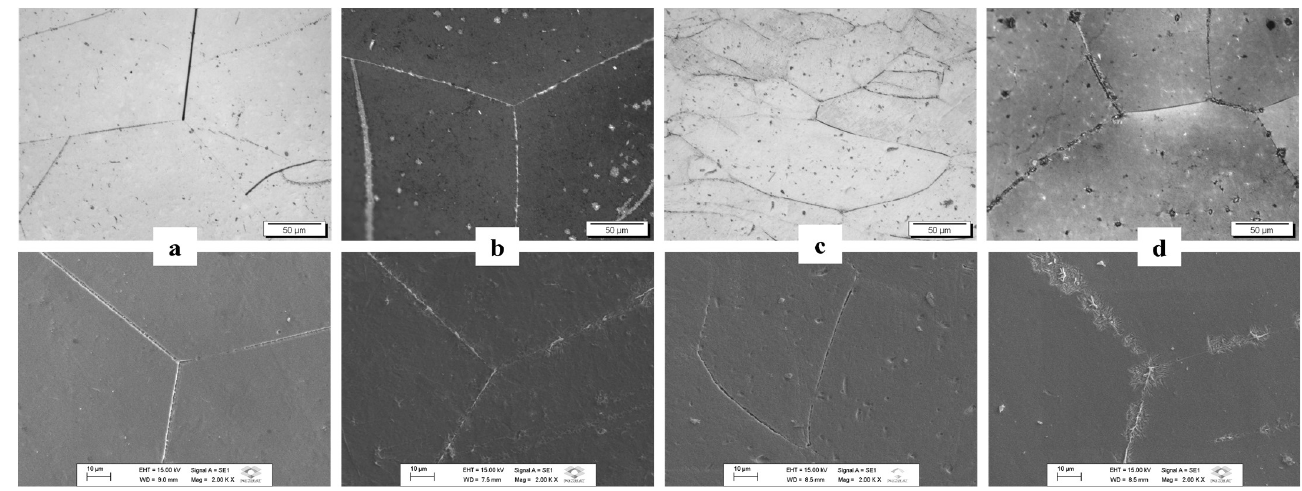
Figure 5. Optical micrographs (above) and SEM micrographs (below) in as-cast ( a ), homogenized ( b ), hot rolled ( c ), and annealed ( d ) conditions, for Ti-20Nb-5Mo samples. The Vickers microhardness values of the studied samples are displayed in Figure